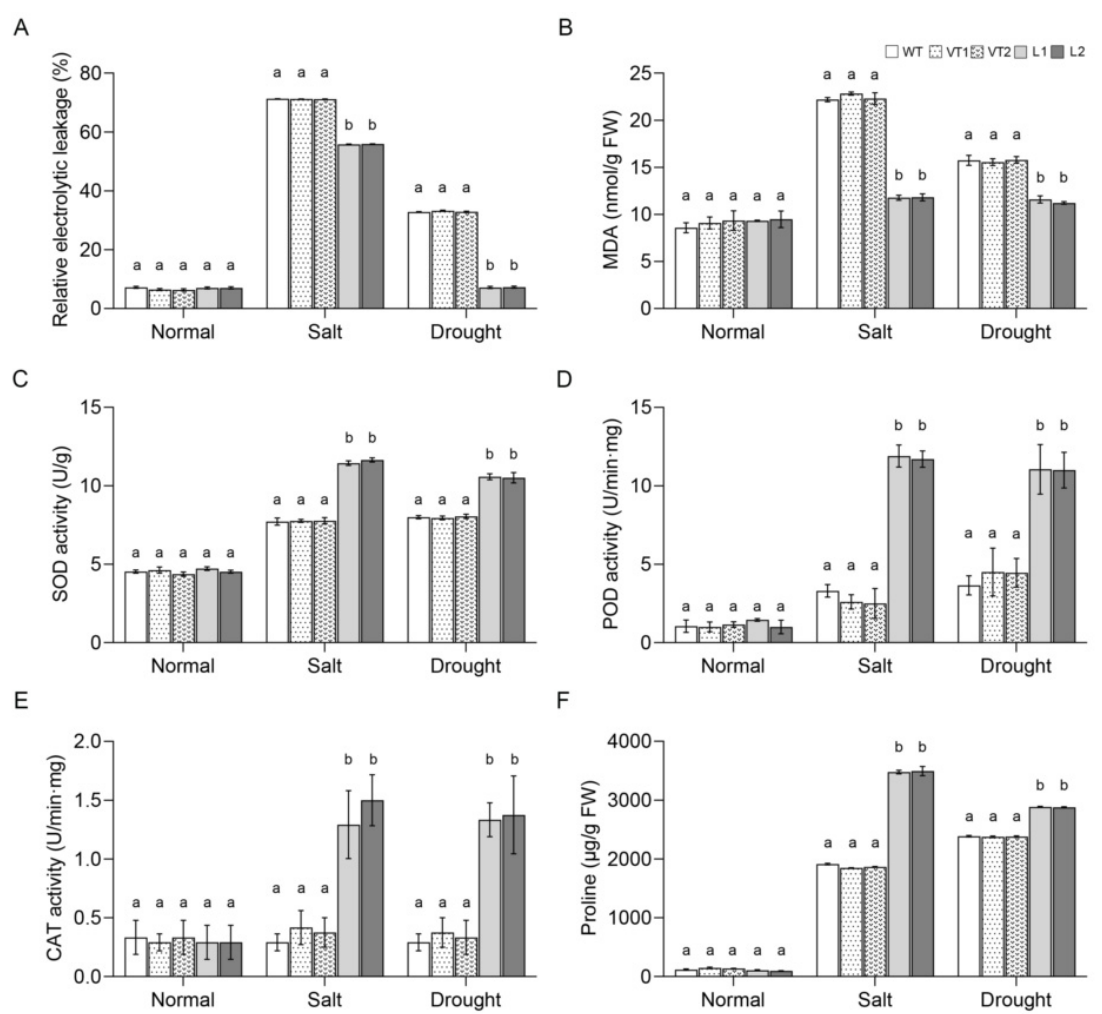
Figure 7. Physiological analyses of Arabidopsis under drought and salt stress. ( A ) The relative electrical conductivity; ( B ) MDA content; ( C ) SOD activity; ( D ) POD activity; ( E ) CAT activity; ( F ) Proline content of wild and transgenic Arabidopsis under normal conditions and stress. The data were means ± SD from three independent replications. Different lowercase letters indicate significant differences between different columns under the same treatment conditions ( p < 0.05).